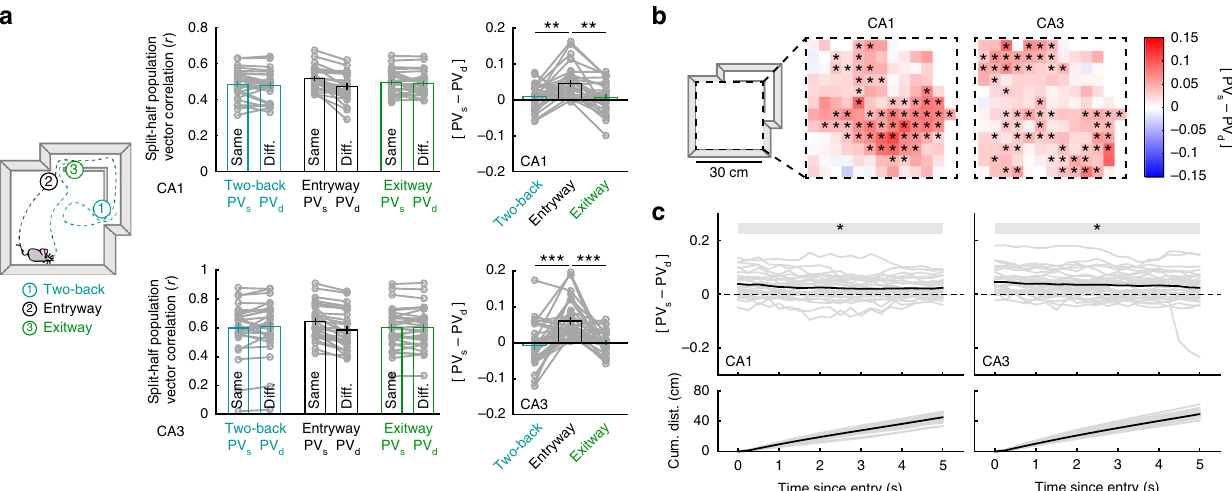
Fig. 3 Remapping is speci fi c to entryway and persists across space and time. a Schematic of trajectory segmentation by the second-most recent entryway into the compartment (Two-back), the most recent entryway, and exitway (left). Split-half correlations of population activity within